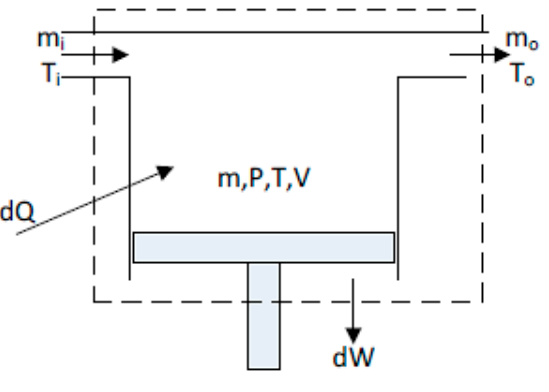
Figure 3. Common control volume [17].